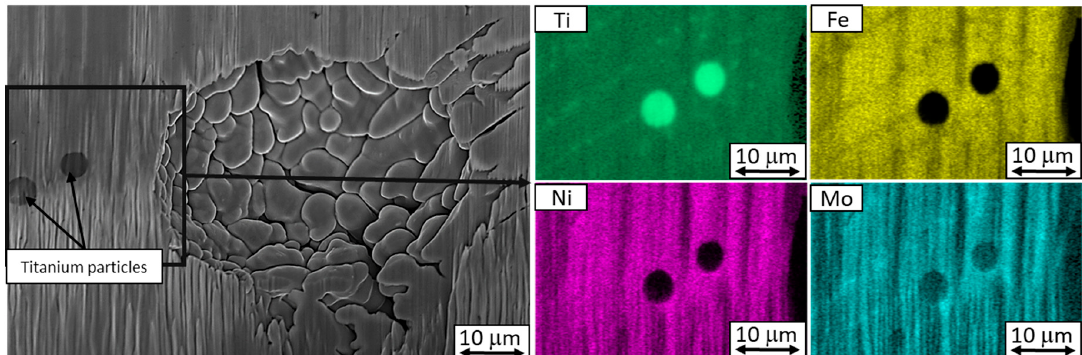
Figure 10. Scanning electron micrograph of an inclusion and titanium particles in a reused powder particle. Cracks can be seen along the boundaries of dendrites. Titanium particles in reused powder are more circular than those in the virgin powder.